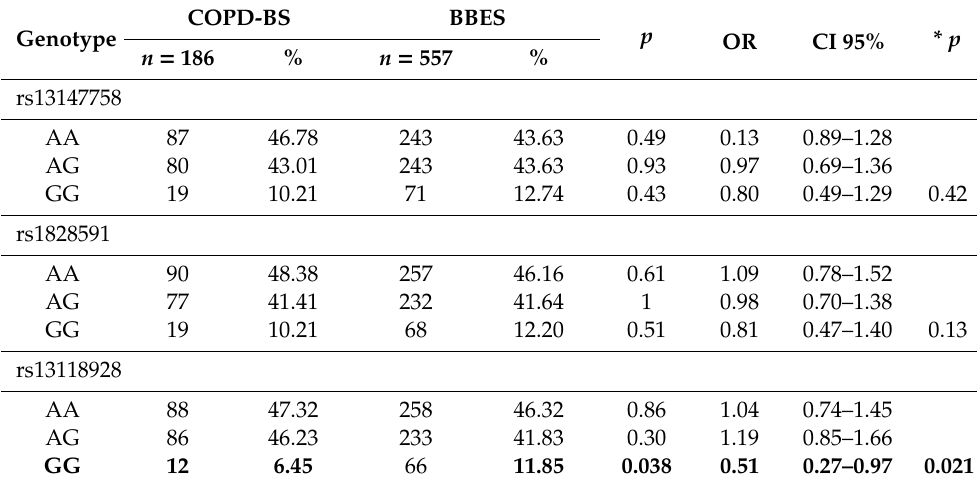
Table 2. Genotype frequencies among study groups.